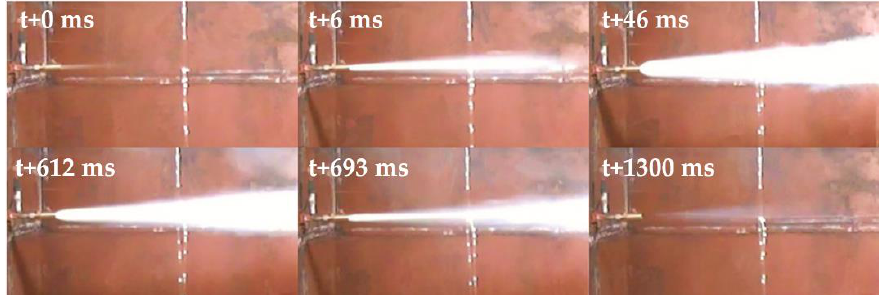
Figure 11. The injection process of HFC-125 agent obtained by the high-speed camera.